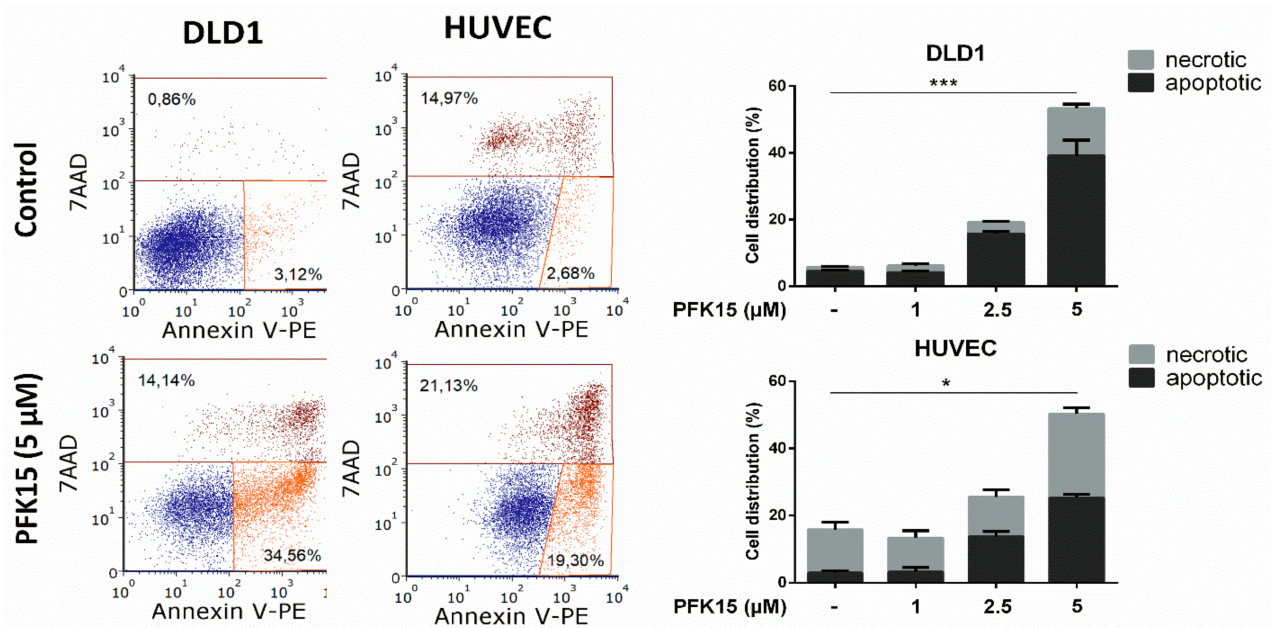
Figure 3. PFK15 induces apoptosis in DLD1 and HUVEC cells cultured in the presence of PFK15 for 48 h. Annexin V assay and subsequent flow cytometric analysis were used for cell death evaluation. Left panel: representative dot-plots from flow cytometric analysis. Right panel: results are presented as mean of triplicates ± SEM. One out of three independent experiments is presented. * p < 0.05, *** p <